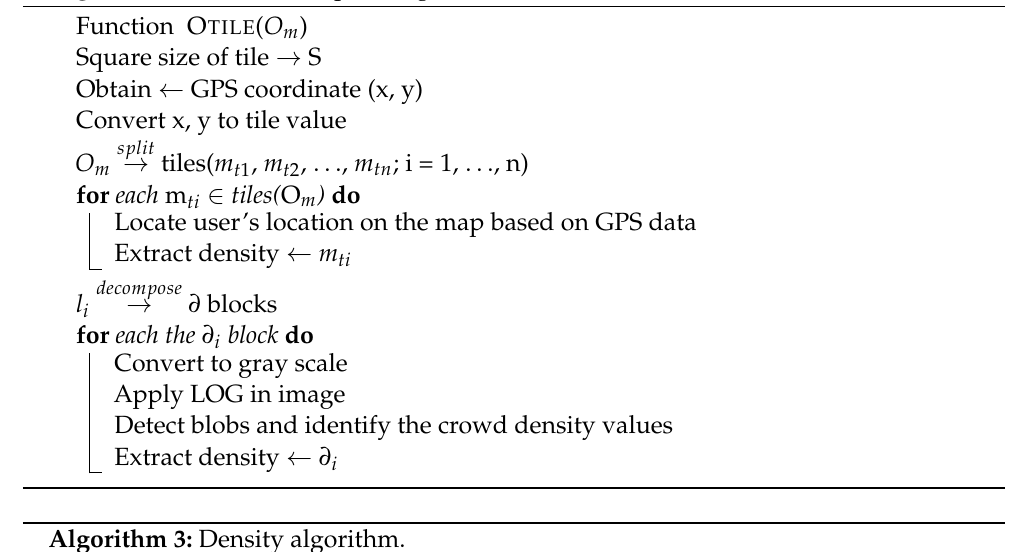
Algorithm 2: Outdoor map tile algorithm.